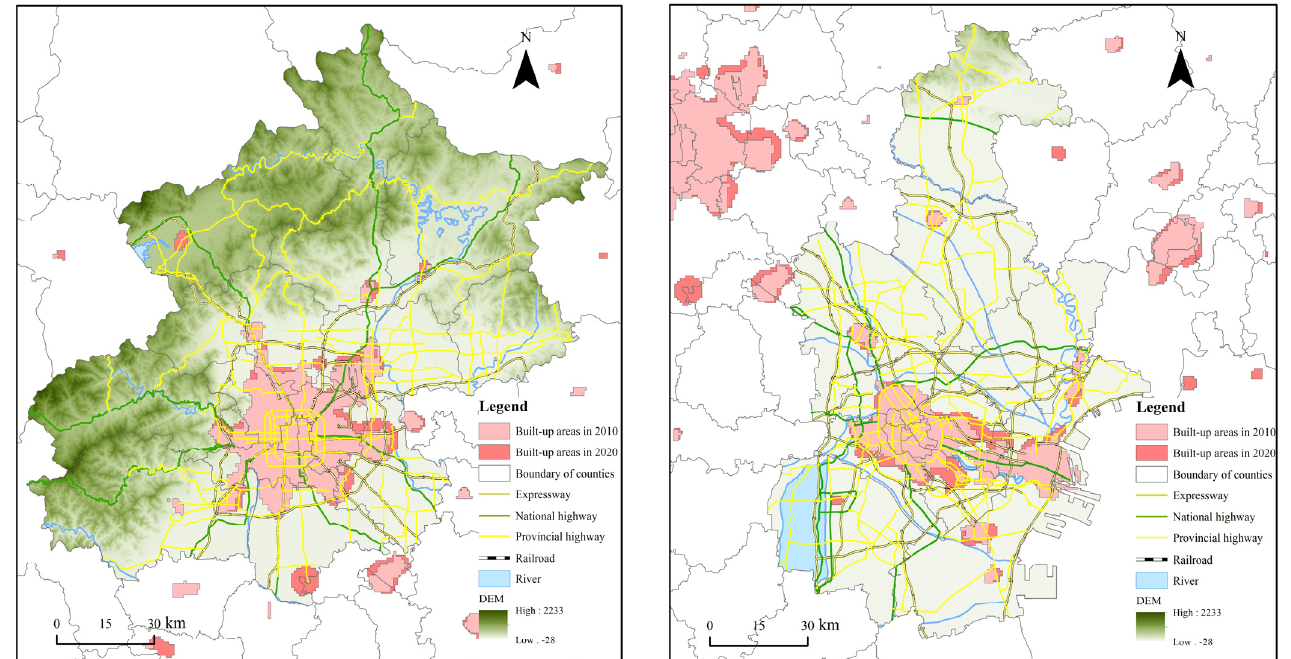
Figure 5. Spatial Expansion Pattern of Beijing and Tianjin from 2010 to 2020.